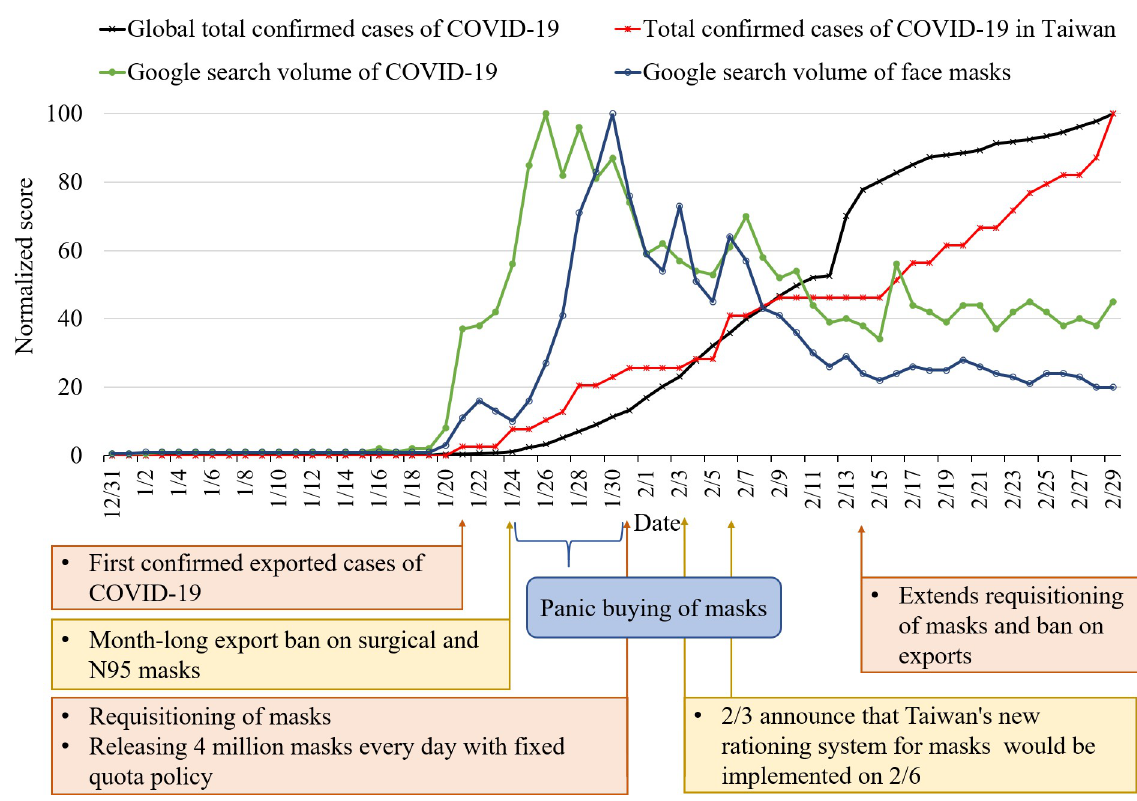
Fig 2. The trend chart for Google search volume for COVID-19 and face masks, and the total confirmed cases worldwide and in Taiwan between December 31, 2019 and February 29, 2020.